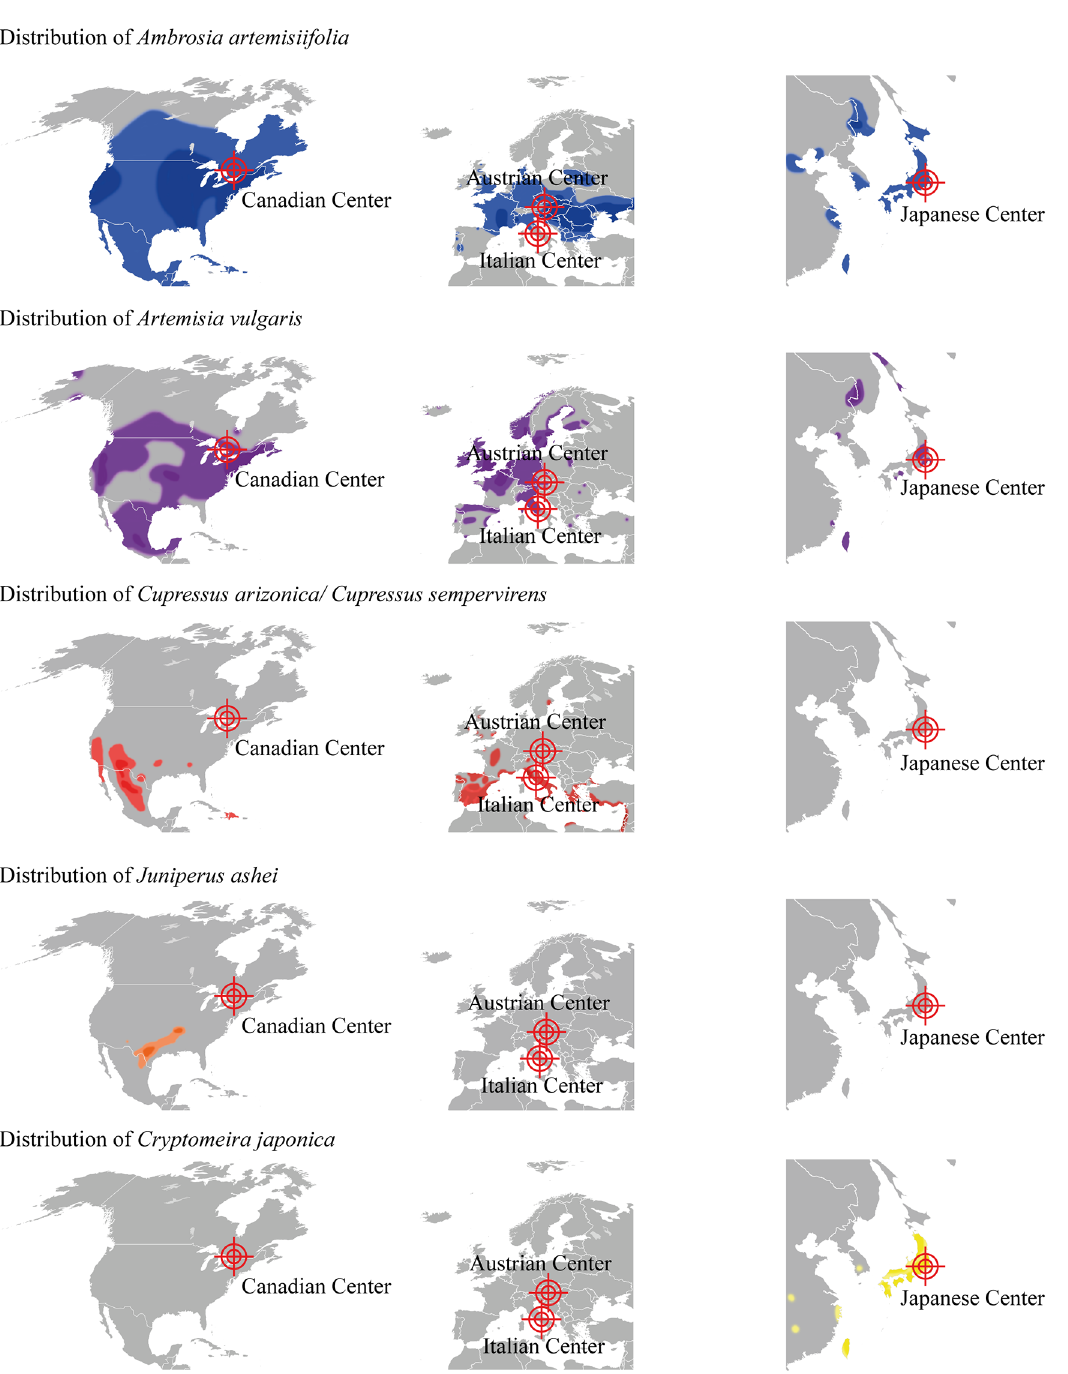
Fig 1. Geographical distribution of plants producing pollen containing clinically relevant allergenic pectate lyases. Light colored zones represent areas with low to medium distribution, dark colored zone areas with high distribution of the respective species. Ambrosia artemisiifolia (ragweed) is presented in blue, Artemisia vulgaris (mugwort) in violet, Cupressus arizonica / Cupressus sempervirens (cypress) in red, Juniperus ashei (Mountain cedar) in orange, and Cryptomeria japonica (Japanese cedar) in yellow. The 4 clinical centers of the study are depict as cross lines (www.gbif.org; www.pollenlibrary.com; eol. org) [3,